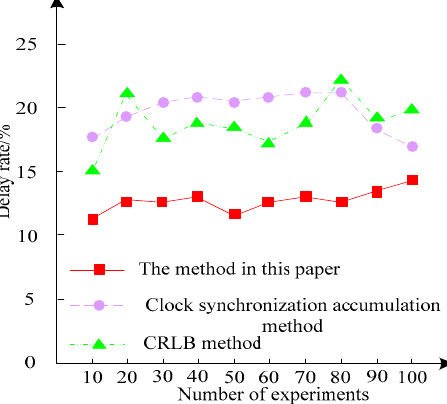
Figure 4. Different methods of sensing communication delay rate.